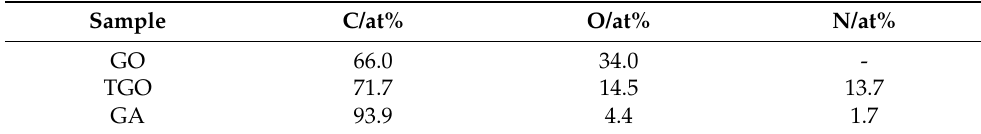
Table 1. Elemental composition of GO, TGO and GA.